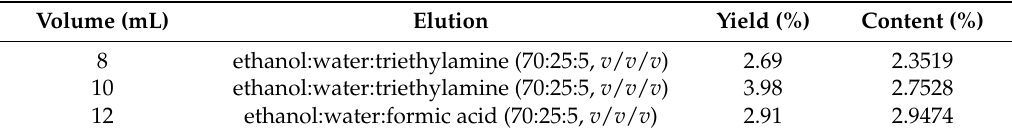
Table 3. Effect of the volume on total alkaloids yield and CEP content from S. cepharantha . Volume (mL)